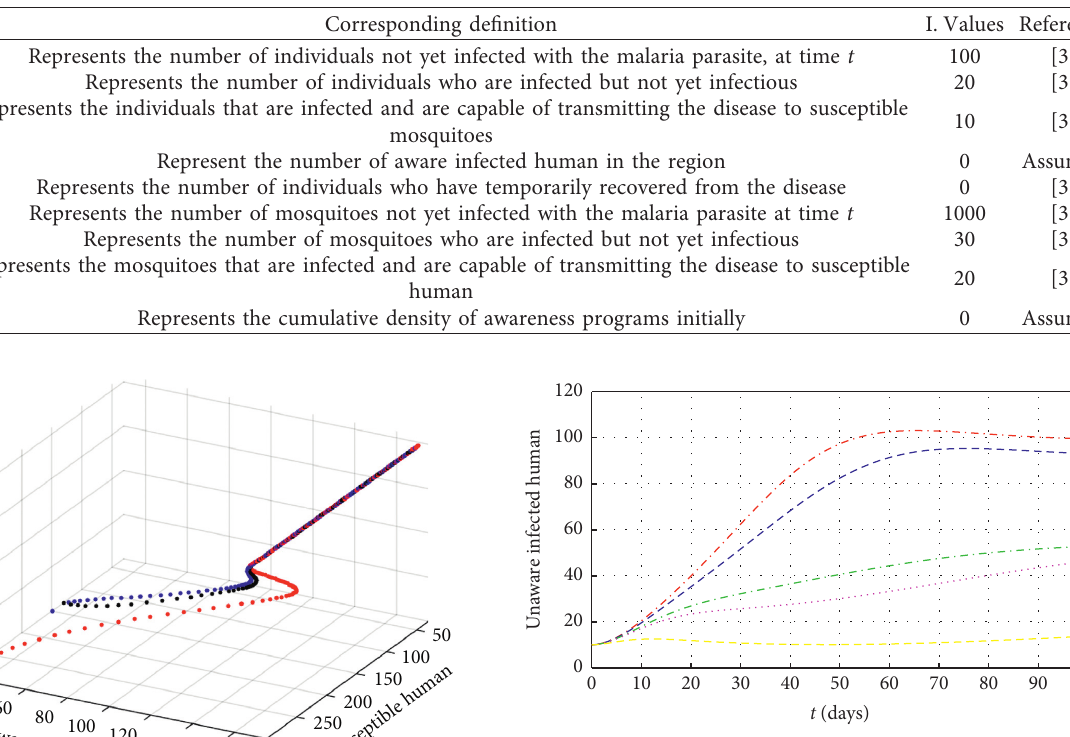
Table 2: Definition and values of variables used in the model.